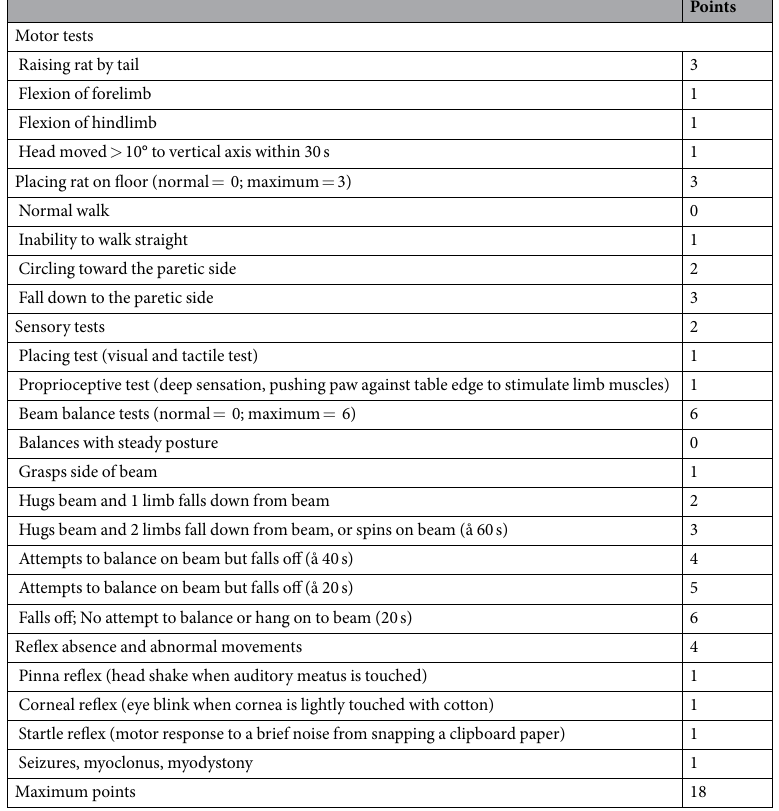
Table 1. Modified Neurological Severity Score (mNSS). One point is awarded for the inability to perform the tasks or for lack of a tested reflex, 13–18, severe injury; 7–12, moderate injury; 1–6, mild injury.